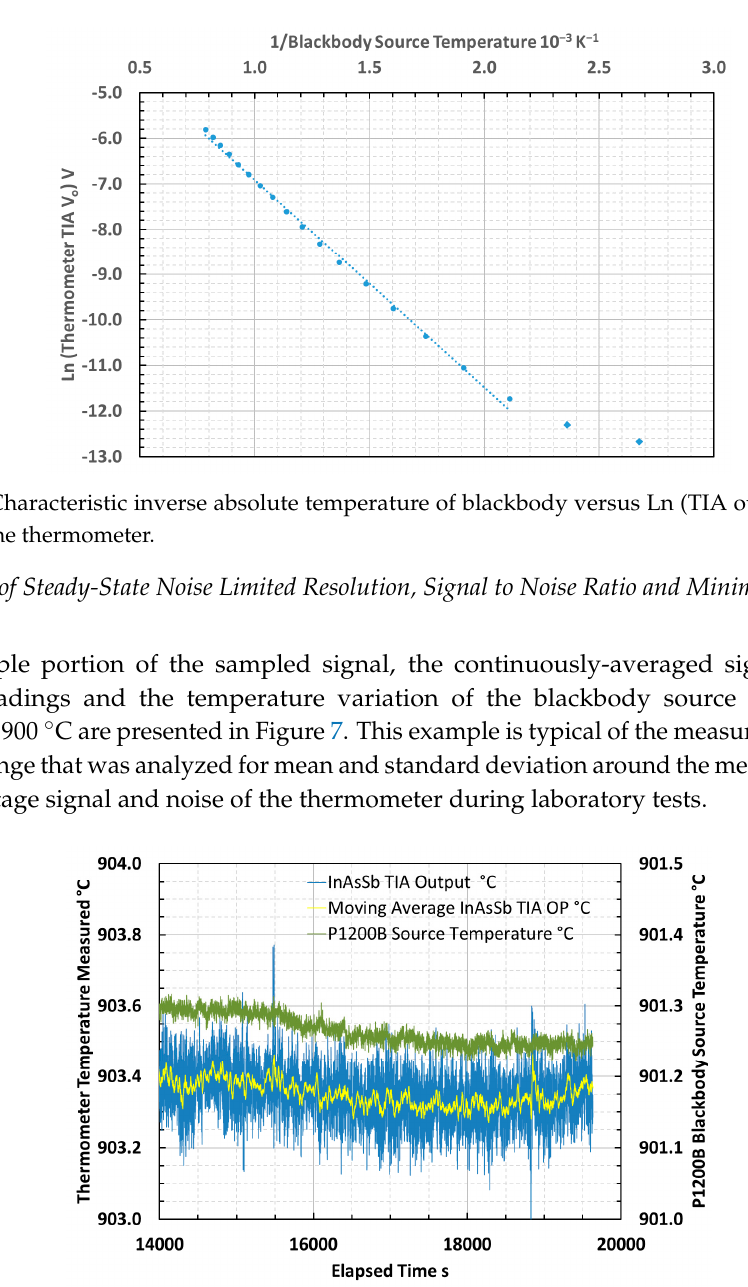
Figure 5. Output voltage of the infrared thermometer as a function of source temperature.